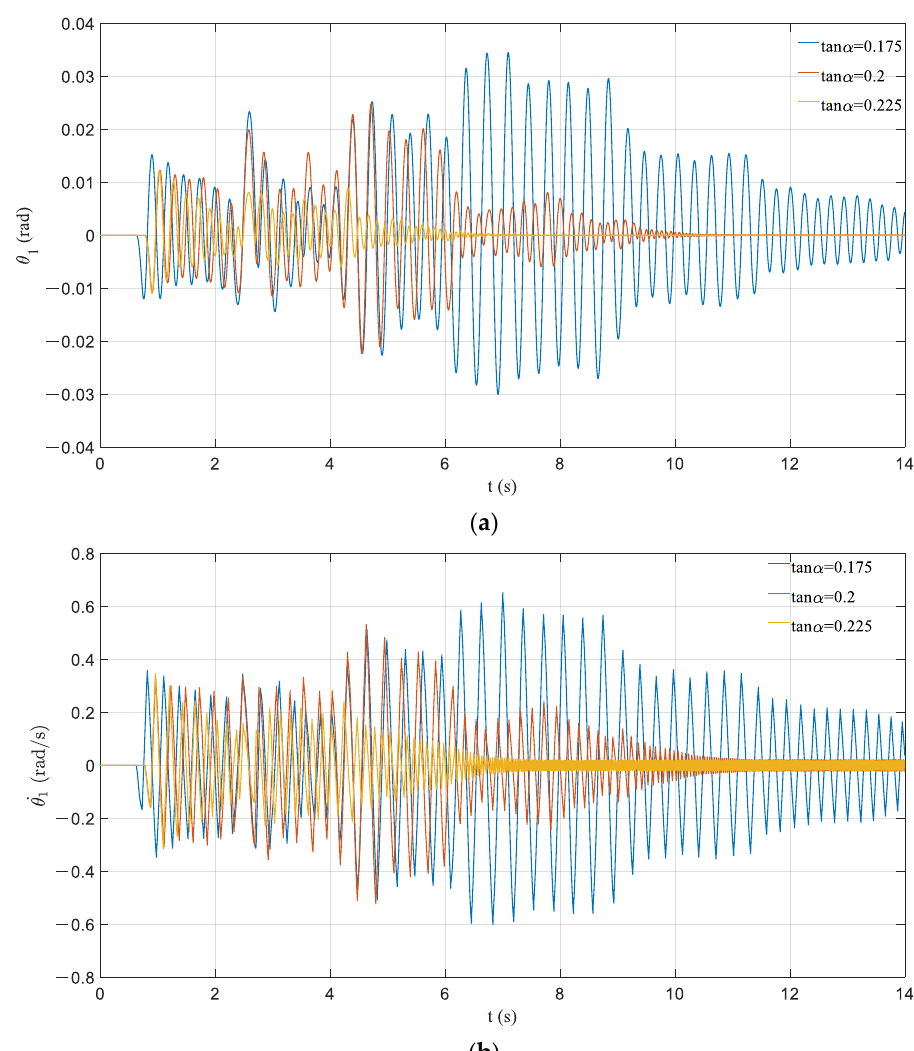
Figure 15. Effect of variation in tan α : ( a ) time history of rocking rotation; ( b ) time history of angular velocity.